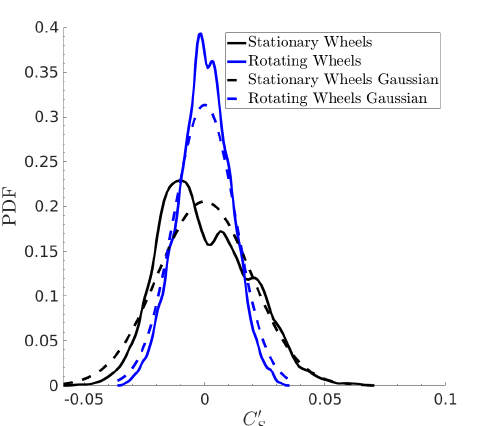
Figure 9. Probability density function (PDF) of the side-force coefficient C S filtered at 5 Hz (solid line), in comparison with the PDF of a Gaussian distribution (dashed line).